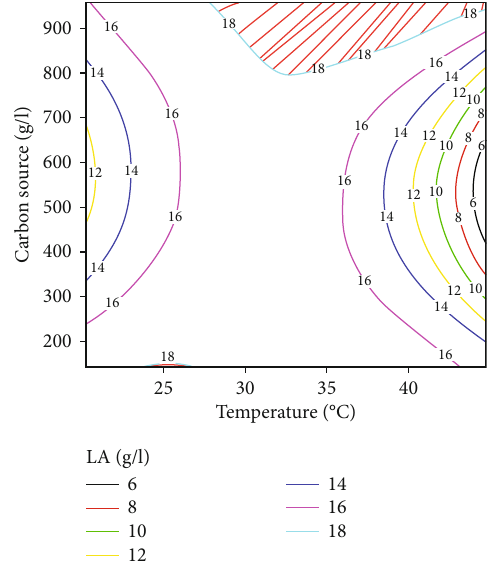
Figure 5: Contour plot showing the e ff ect of carbon source and temperature on lactic acid production.